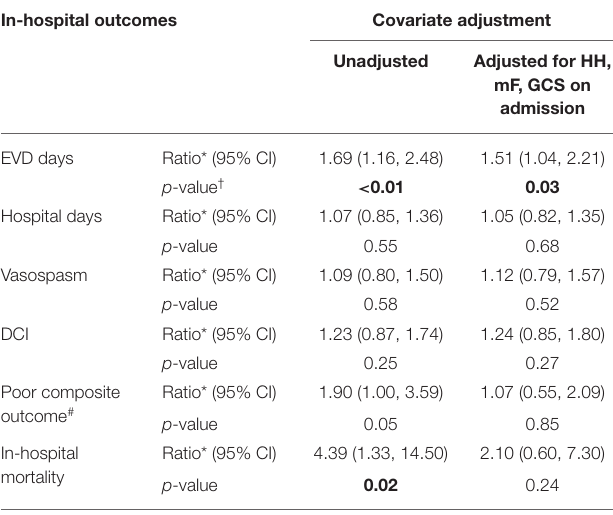
TABLE 4 | Relative difference of major in-hospital outcomes based on admission glycemic gap ≥ 30 mg/dL, adjusted with